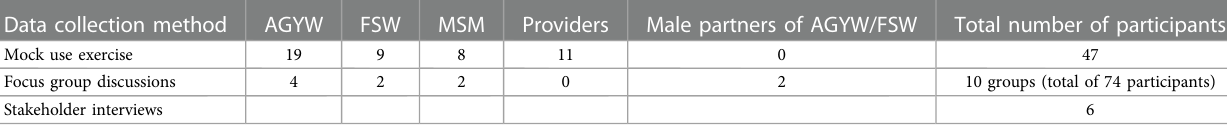
TABLE 2 Study participants, by user group and data collection